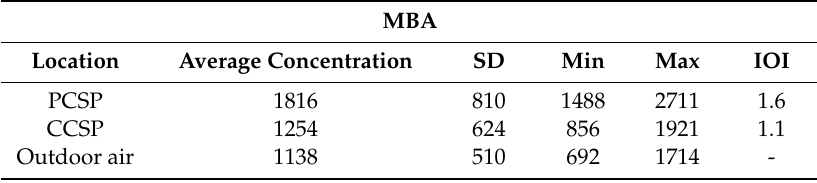
Table 1. Average concentration of mesophilic bacterial aerosol (MBA) colony-forming units (CFUs) per cubic meter (CFU / m 3 ) and the indoor–outdoor index (IOI) of the air inside and outside the sorting plant.